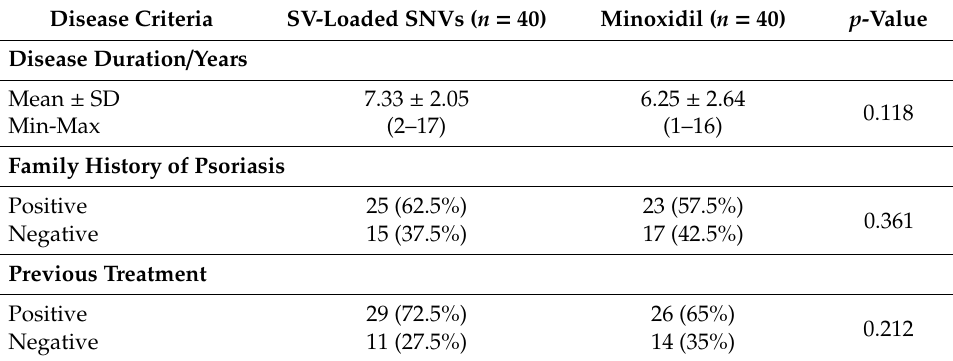
Table 6. Comparison of the disease criteria among the studied